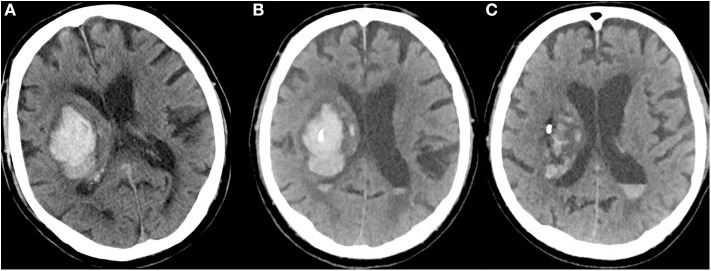
(A) CT of a 79-year-old man with a right-sided, VKA-related deep ICH at admission (NIHSS = 14; INR = 3.0; hematoma volume: 58 ml). (B) CT after bedside catheter placement and aspiration of 11 ml of blood shows that the catheter tip is well positioned in the core of the hematoma (after administration of 4000 PCC, INR = 1.2). (C) After application of urokinase (5000 IE every 6 h) for four consecutive days, the hematoma volume had decreased to 21 ml (NIHSS = 10).